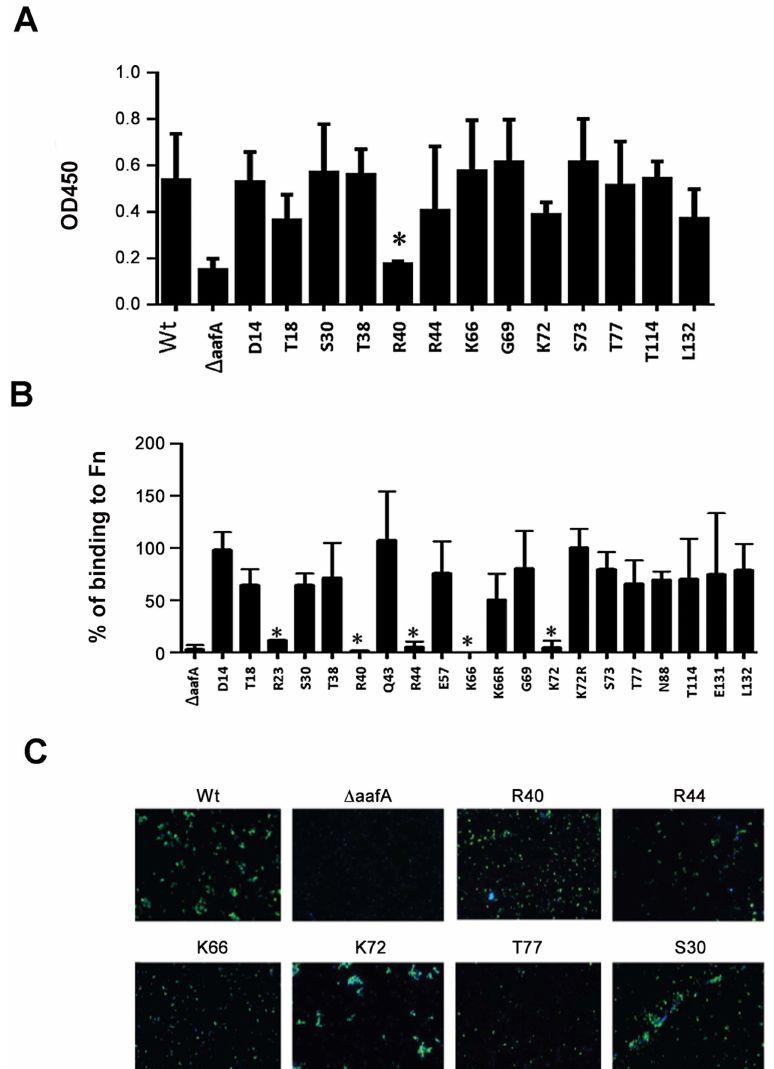
Figure 5. Involvement of AafA and site-directed-mutants in biofilm formation and binding to fibronectin. (A) Biofilm quantification. Bacteria were cultivated in LB for 20 h at 37 u C in 24-well dishes and induced with 0.2% arabinose. Biofilms were fixed and stained with crystal violet, and then the stains were solubilized and quantitated spectrophotometrically at 450 nm. The bars represent the means of the results from triplicate wells; error bars indicate one standard deviation. Wt, wild type EAEC042, D aafA, EAEC042 aafA mutant. All residues tested were mutated to Ala except Thr18Ile and Thr38Leu. *, P , 0.005. (B) Fibronectin binding. EAEC 042 derivatives harboring site mutations in aafA were added to 96-well plates coated separately with 25 m g/ml of fibronectin, and the binding was determined by collecting the cells adhered to wells by scraping them into PBS. The number of adherent bacteria was determined by counting the resulting colonies in duplicate and normalized to the wild type adherence (as a 100% adherence). The bars represent the means for three experiments, with the error bars indicating 1 standard deviation. *, significantly different from EAEC042WT ( P , 0.005).(C) AafA surface expression. After induction of bacterial strains with 0.2% arabinose, cells were harvested, washed twice with PBS, and incubated with a polyclonal anti-aafA antibody (2 m g/ml) in PBS plus 1% bovine serum albumin for 1 h at room temperature with agitation. They were washed twice with PBS and incubated with a goat anti-rabbit IgG-fluorescein isothiocyanate (FITC) conjugate (10 m g/ml) for 30 min at room temperature in the dark. The washings were repeated, and the samples were resuspended in DAPI (4 mg/liter) and spread on slides for viewing by fluorescence microscopy.